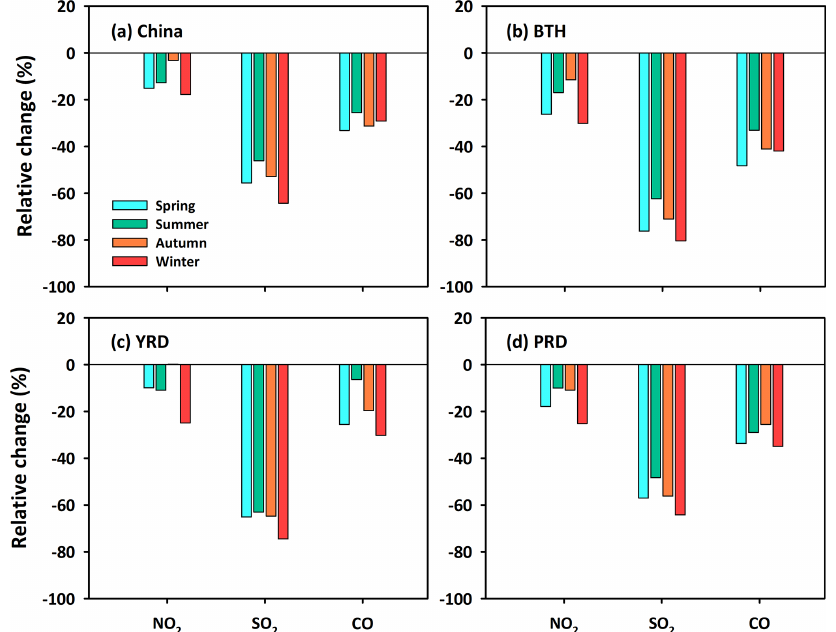
Figure 6. Relative changes (%) in seasonal mean surface NO 2 , SO 2 , and CO concentrations between 2013 and 2020 over (a) China, (b) the Beijing–Tianjin–Hebei (BTH) region, (c) the Yangtze River Delta (YRD), and (d) the Pearl River Delta (PRD).